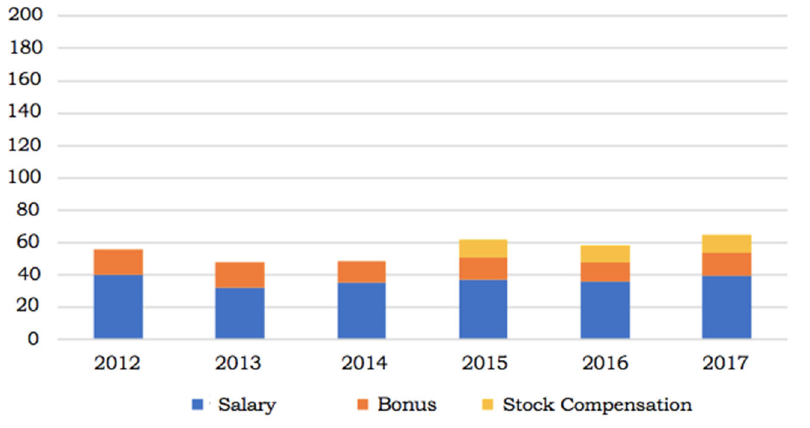
Figure 5. Classified average executive compensation in KDDI Note: Vertical axis indicates the amount of average executive compensation and horizontal axis indicates fiscal